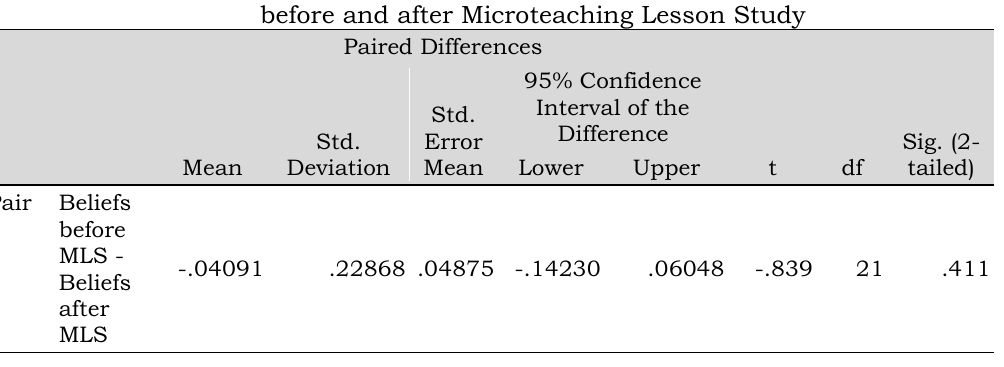
Table 2. Paired Sample t-test of the Beliefs of the EFL Student Teachers